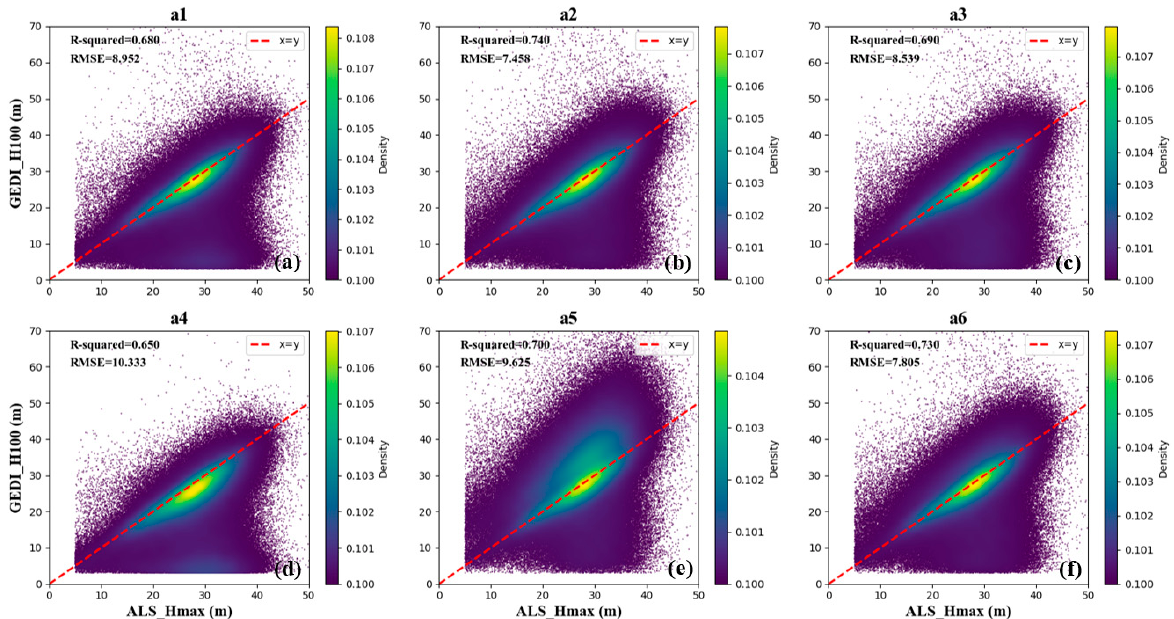
Figure 3. G EDI-H100 versus ALS-Hmax for each algorithm setting group (( a )–( f ) for algorithms a1 Figure 3. GEDI-H100 versus ALS-Hmax for each algorithm setting group (( a – f ) for algorithms a1 to a6 ). to a6 ).